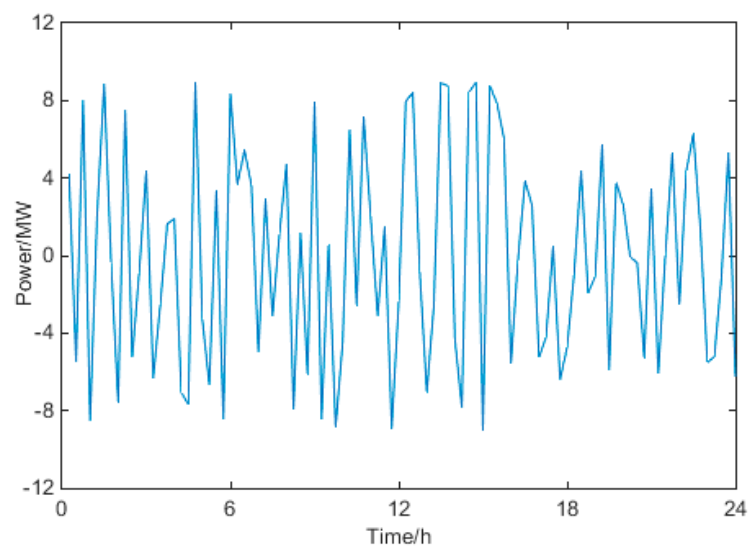
Figure 9. The output curve of energy storage resources of typical scenario 12.